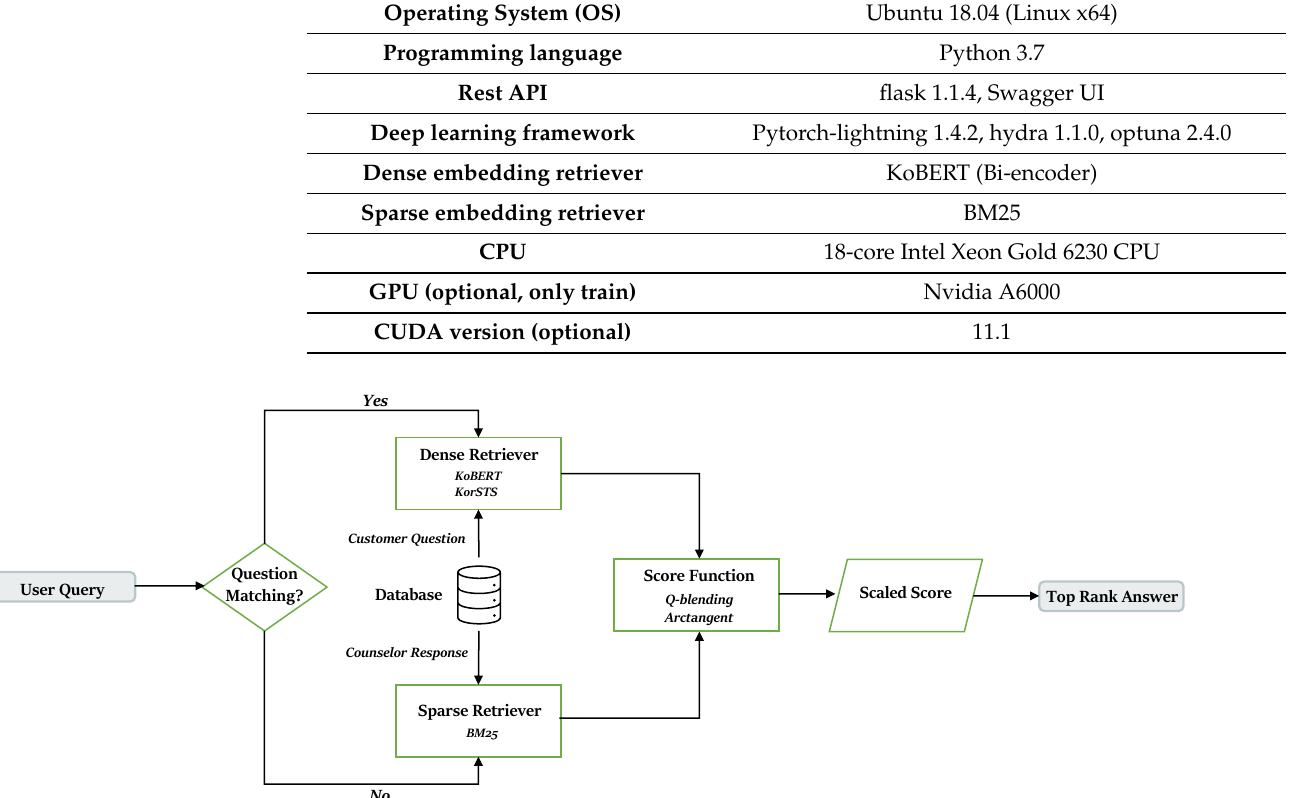
Figure A1. Flowchart of proposed FAQ retriever system. The proposed system uses a different model of whether to retrieve the counselor response or the customer question in the